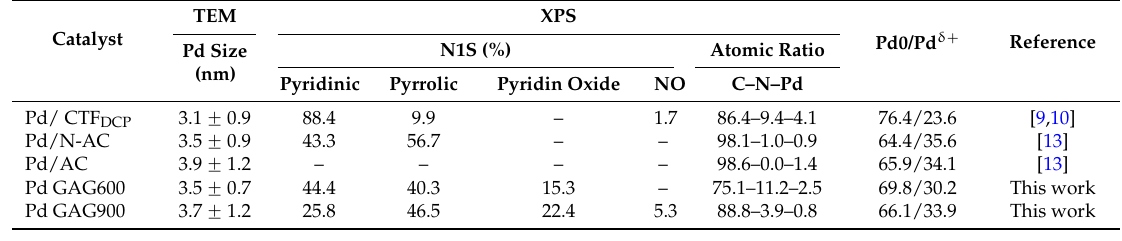
Table 4. Characteristics of Pd catalysts.